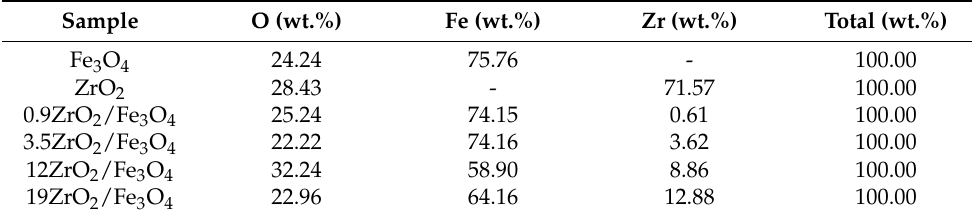
Table 1. Mass composition of the materials characterized by the EDS method.